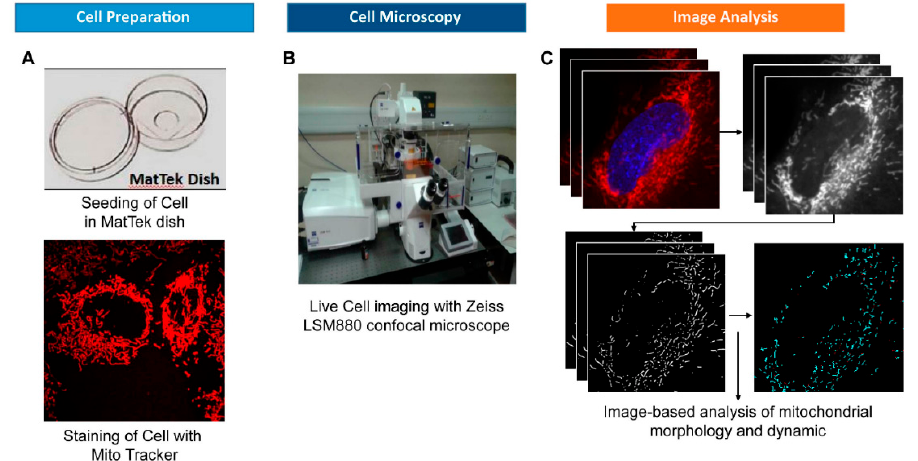
Figure 2. Workflow of the quantitative analysis of mitochondrial networks in live cells. ( A ) Basic instruction for mitochondrial network staining with Mito Tracker Red and cell imaging. ( B ) The living cell mitochondrial video was captured using high resolution confocal laser scanning microscopy LSM880. The video was recorded at an average of 12 seconds per frame in order to capture super high-resolution images. A total of 24 frames of video per cell were recorded for mitochondrial dynamic analysis. ( C ) Each frame was preprocessed using Fiji / ImageJ’s Gaussian blur filter with kernel size 3 to remove the background noise. The filtered images were analyzed using Mytoe to detect the detail of the mitochondrial branch, and to measure its size, moving speed, and moving patterns .